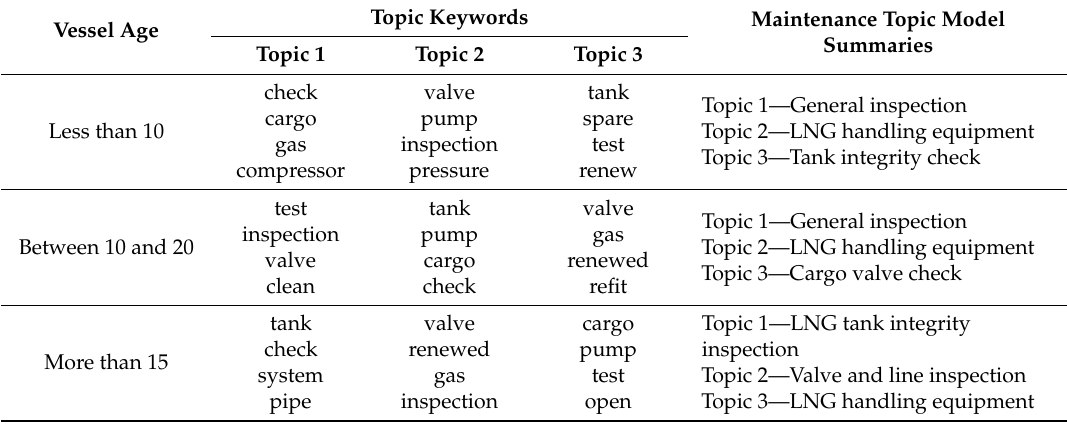
Table 3. Top ranking keywords and maintenance topic summaries. Topic Vessel Age